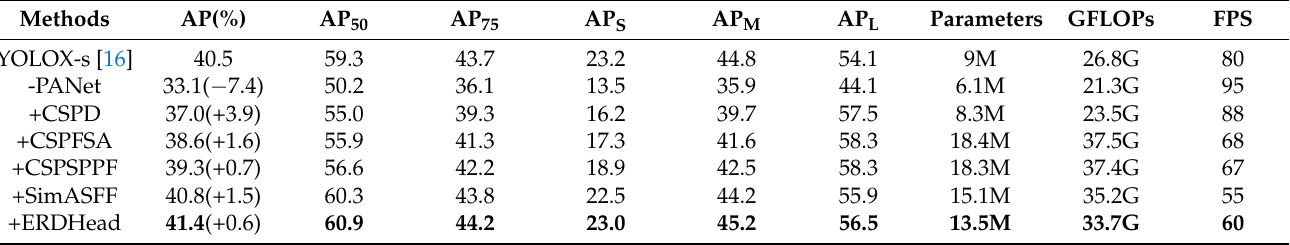
Table 1. Ablation experiments of EYOLOX in terms of AP (%) on COCO-2017 val. All the models are tested at 640 × 640 resolution, with FP16-precision and batch = 1 on a NVIDIA A40. The FPS in this table are